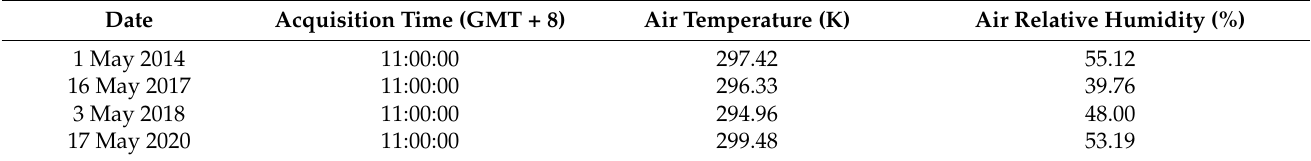
Table 2. Ground meteorological observation data at satellite transit